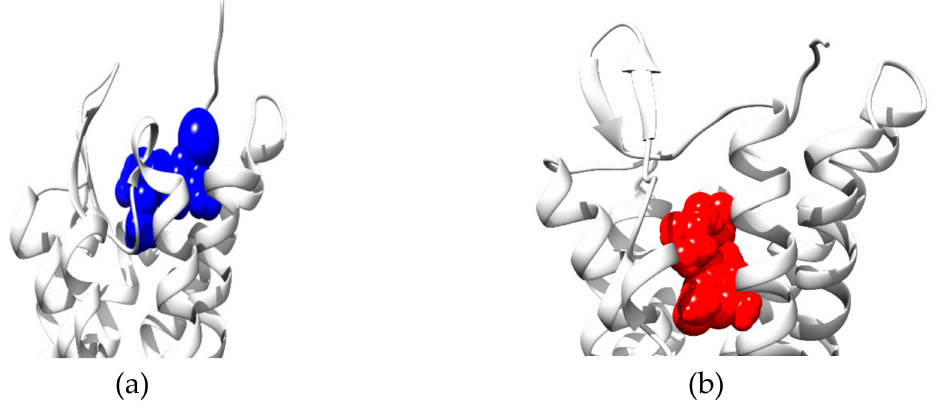
Figure 6. P2Y 1 R binding sites for ( a ) MRS2500 and ( b )